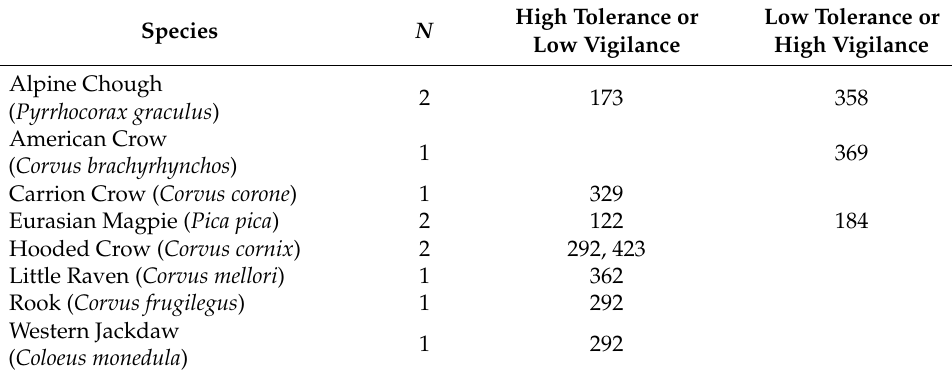
Table 10. List of papers about corvids’ tolerance towards humans ( n = 9). The reference numbers in the table refer to the individual publication numbers given in Table S2.